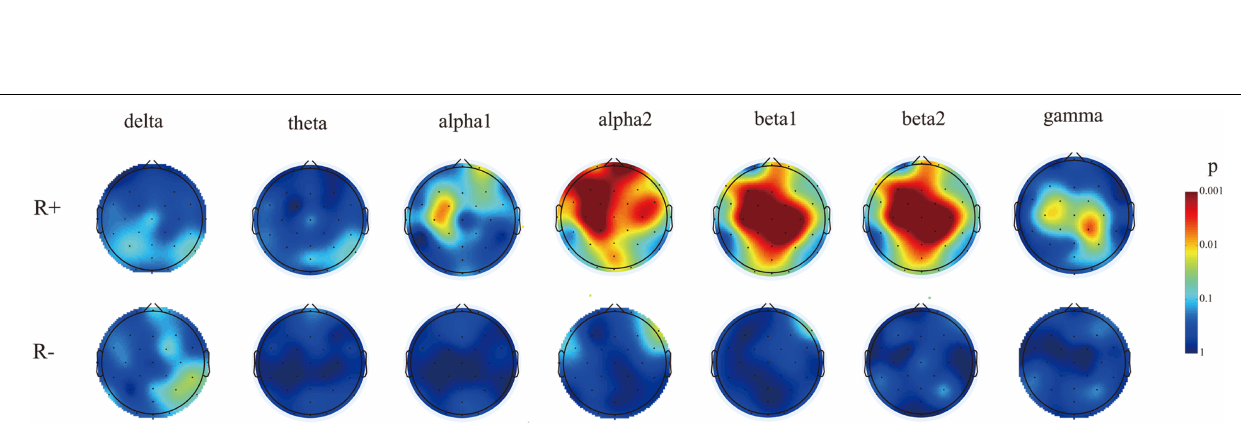
FIGURE 2 | Behavioral response to tDCS. (A) The proportion of each state of consciousness, before and after tDCS showed an increase in the higher states of consciousness [emergence from minimally conscious state (eMCS) and minimally conscious state “plus” (MCS +)], at the expense of lower states of consciousness [vegetative state (VS) and MCS “minus” (MCS − )]. (B) Individual patients’ CRS-R scores before and after tDCS are represented with the number of patients and their state (symbols). Significant difference in scores before and after stimulation is found ( p = 0.0066).